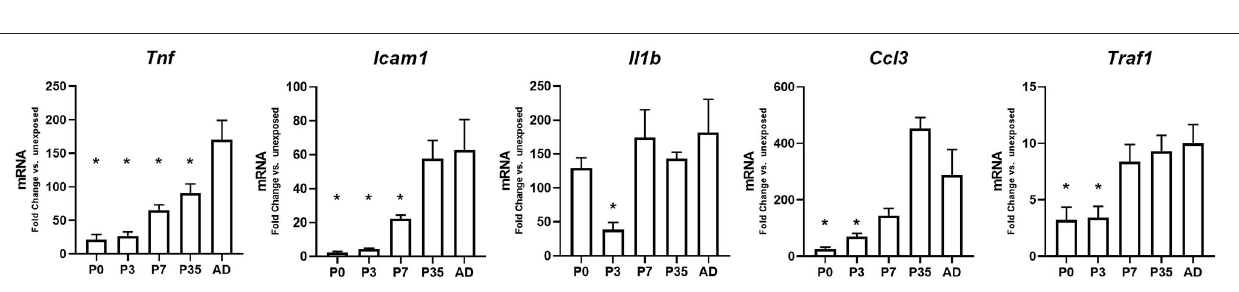
FIGURE 5 | Endotoxemia induces developmentally-regulated hepatic expression of primary pro-inflammatory genes. Hepatic gene expression levels for primary innate immune pro-inflammatory genes 1-h post IP LPS at different developmental time points. * P < 0.05 vs. adult (AD) by 1-way ANOVA and Dunnet post-hoc test. Values are represented as fold change compared to their own unexposed